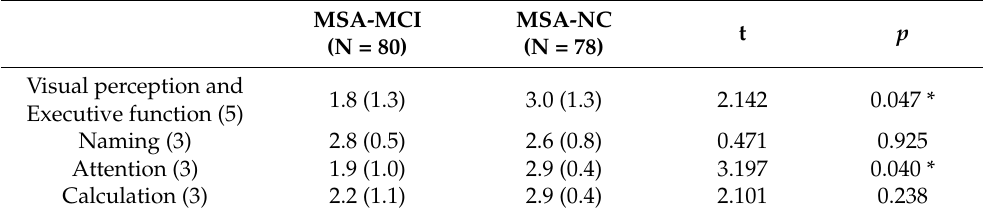
Table 4. Cognitive profiles in patients with MSA-MCI on the